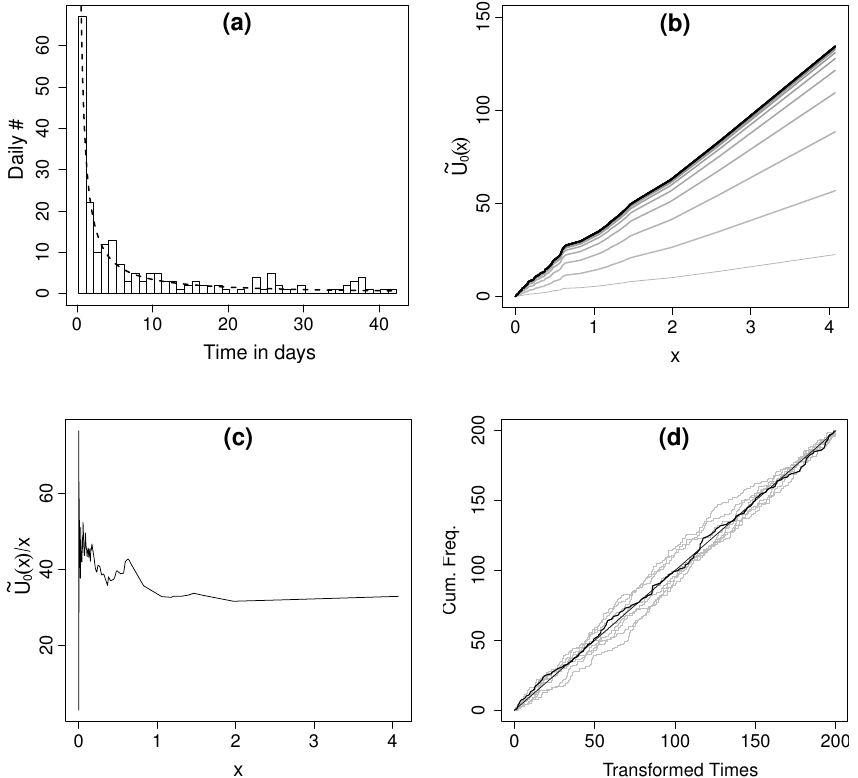
Figure 2. ( a ) Daily occurrence numbers of the M S 4.0+ Wenchuan aftershocks and the dashed line represents the intensity function from fitting the original Omori–Utsu formula to this dataset; ( b ) convergence steps of ˜ U 0 ( x ) : the iteration steps are indicated by different grayscale colors from the lightest gray for the initial step to the darkest for the final results; ( c ) Ratio of the final estimate ˜ U 0 ( x ) to U 0 ( x ) = x in the Omori–Utsu formula modulated renewal model; ( d ) the cumulative numbers of events against the transformed